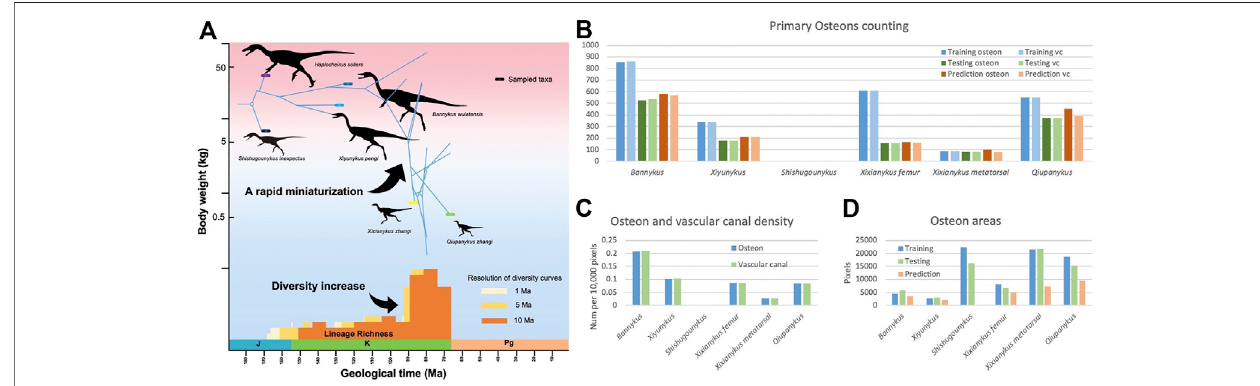
FIGURE 4 | (A) . simpli fi ed Alvarezsauria phylogeny including taxa used in this study, modi fi ed from Qin et al. (2021). (B) . Number of primary osteons and vascular canal in training, testing, and predicting datasets. (C) . Average density of vascular canal in primary osteons. (D) . Average areas of primary osteons.